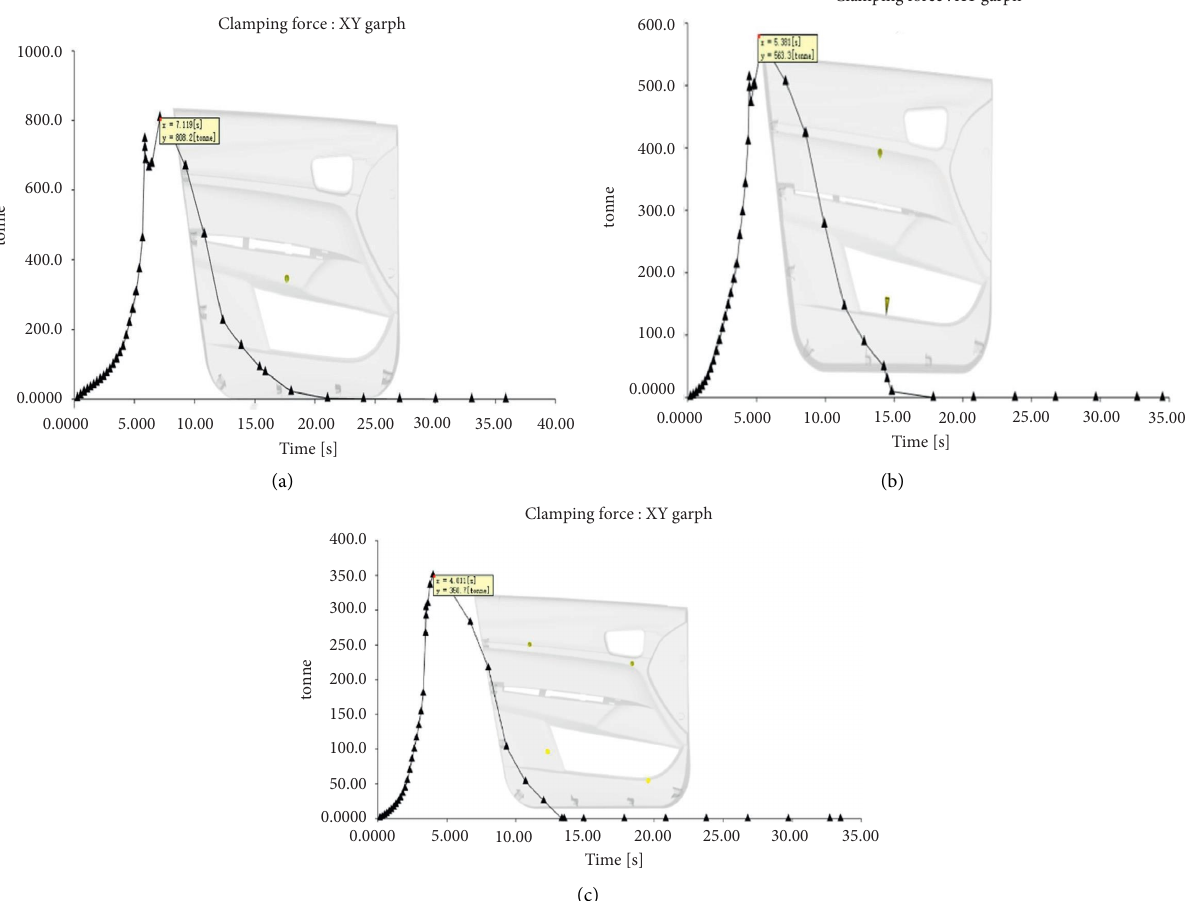
Figure 7: Clamping force of three gate location schemes. (a) Single gate. (b) Two gates. (c) Four